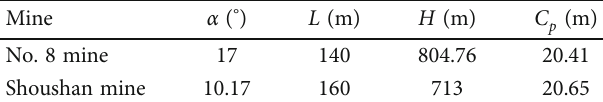
Table 1: List of disturbance damage depths of the Ji Group coal fl oor (m).